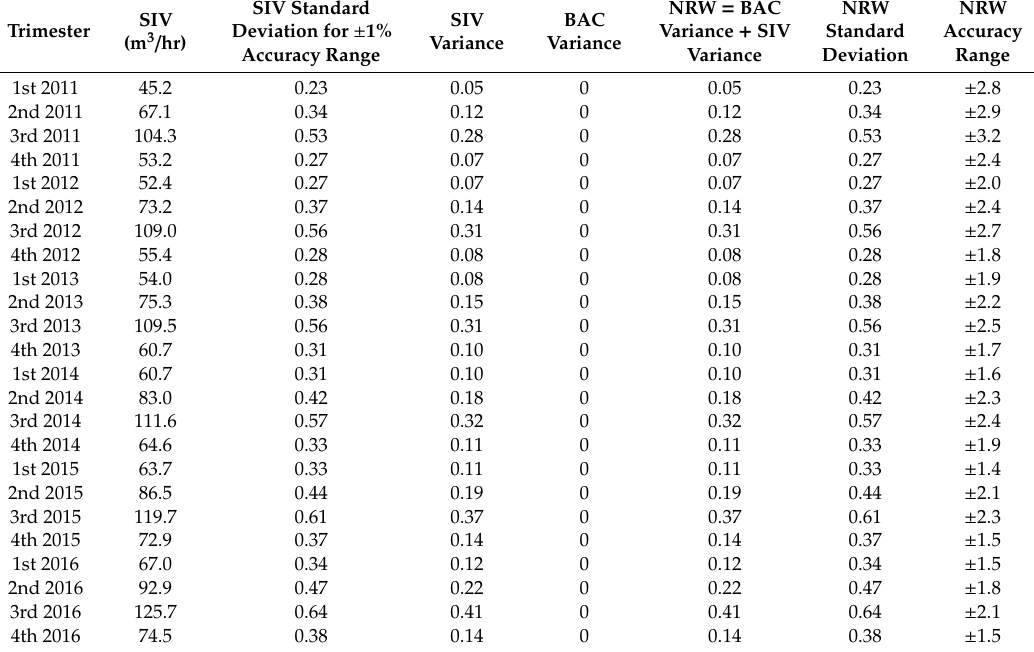
Table 1. Application of 95% confidence limits to the water balance (WB) and estimation of the accuracy ranges of